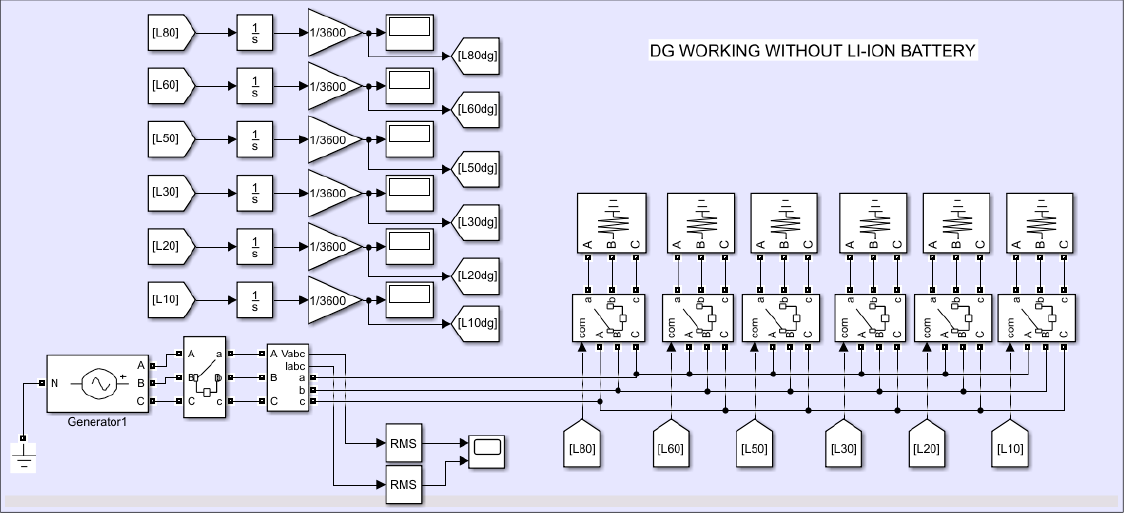
Figure 3. DG working without Li-ion battery.